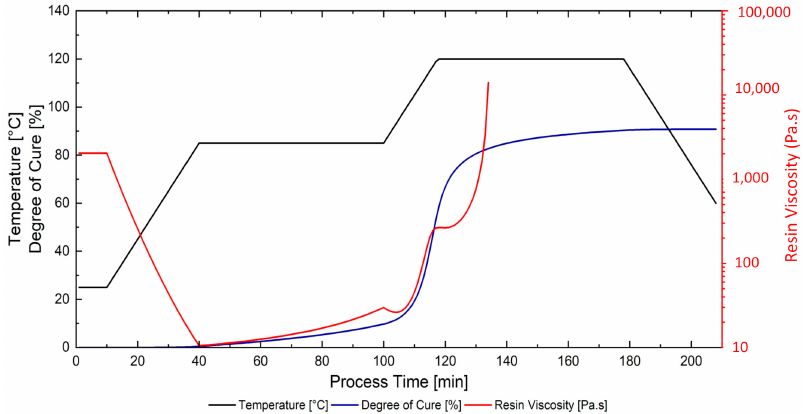
Figure 6. Process cycle for the cured laminates: oven temperature profile and numerically predicted resin degree of cure and